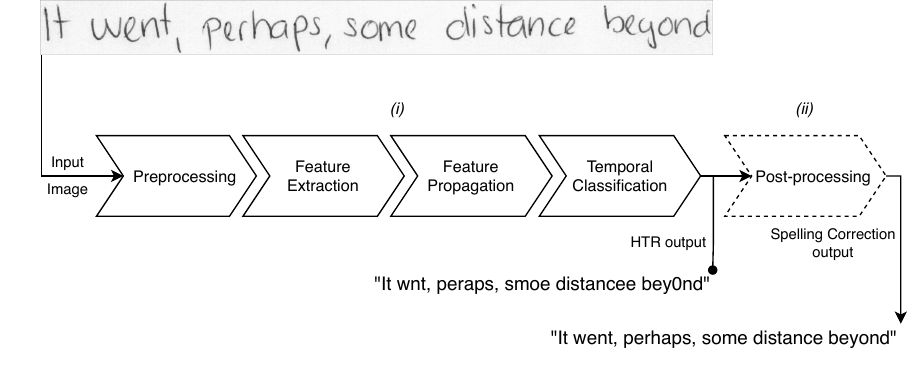
Figure 5. Proposed system